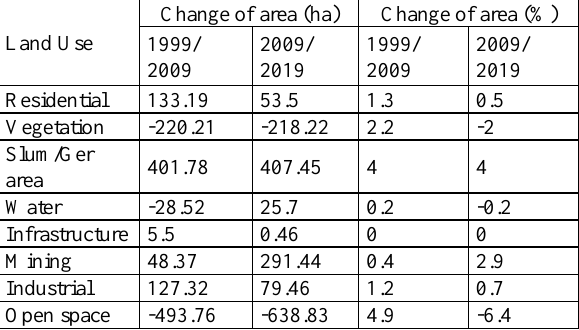
Table 5. LUCC of Darkhan city